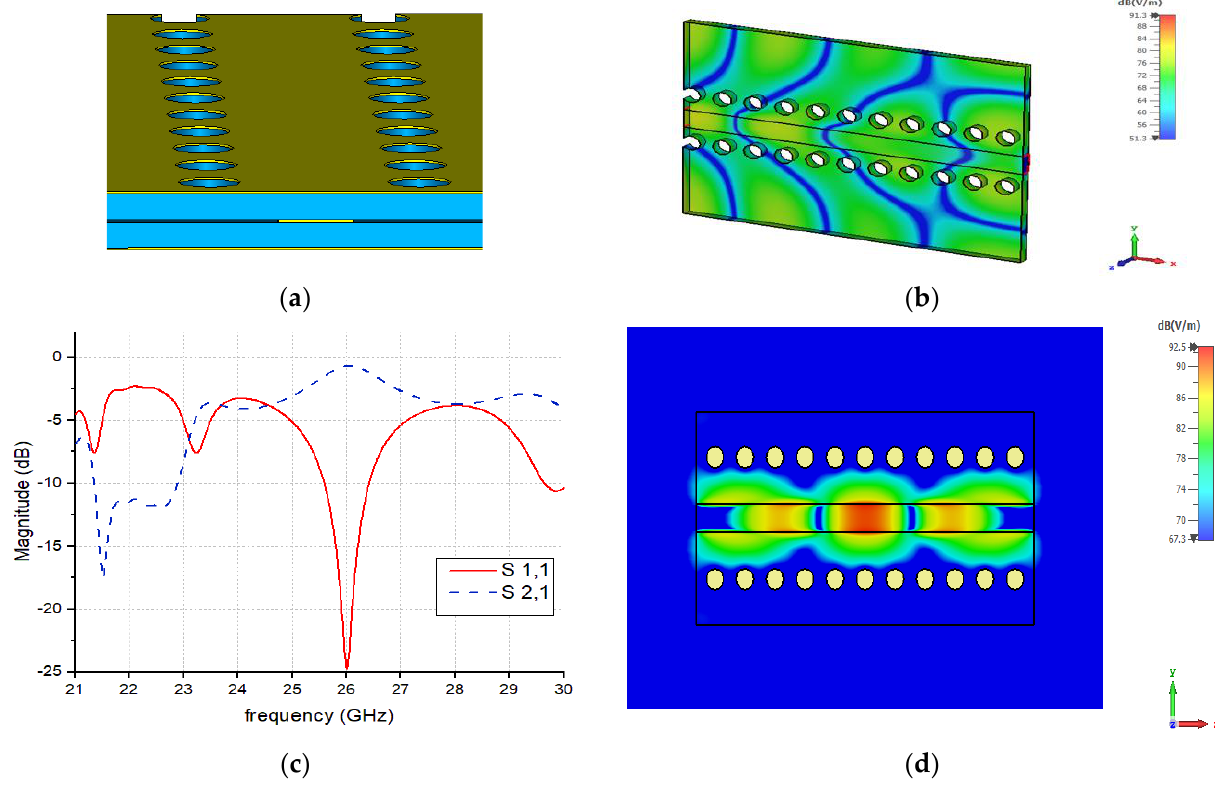
Figure 3. ( a ) Introduced gap between two dielectric layers; ( b ) E-fields at cutting plane to show leakages inside the gap; ( c ) S-parameters of the optimized SICL line; ( d ) the magnitude of electric field current distribution of the designed SICL line at 26 GHz frequency.